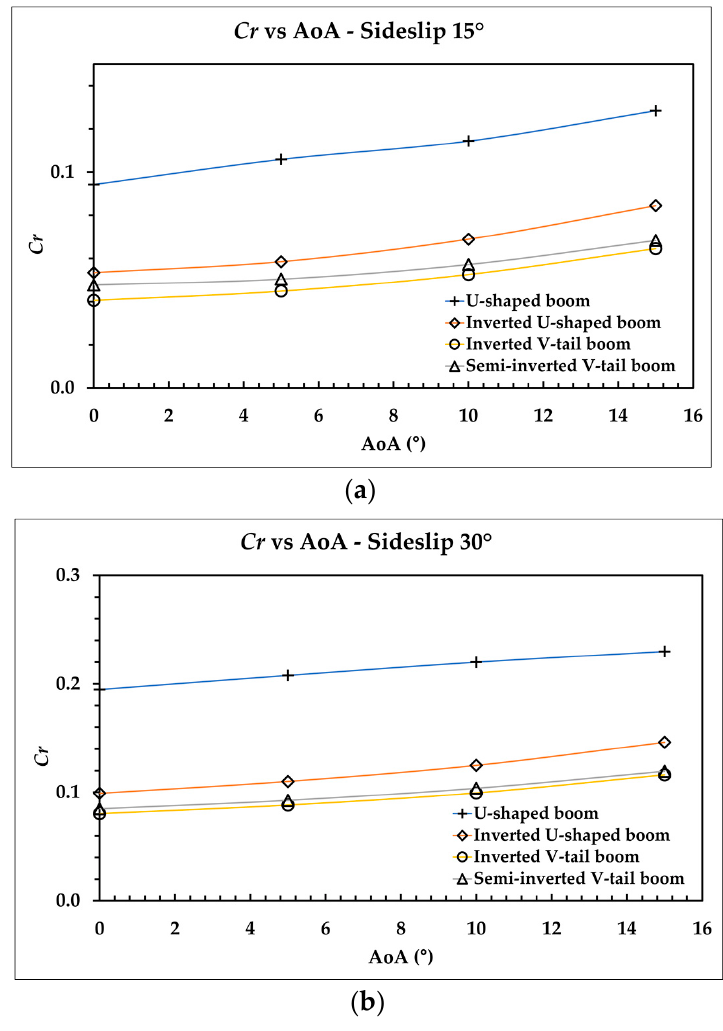
Figure 17. Cr vs. AoA, sideslip angle: ( a ) 15° and ( b ) 30°.